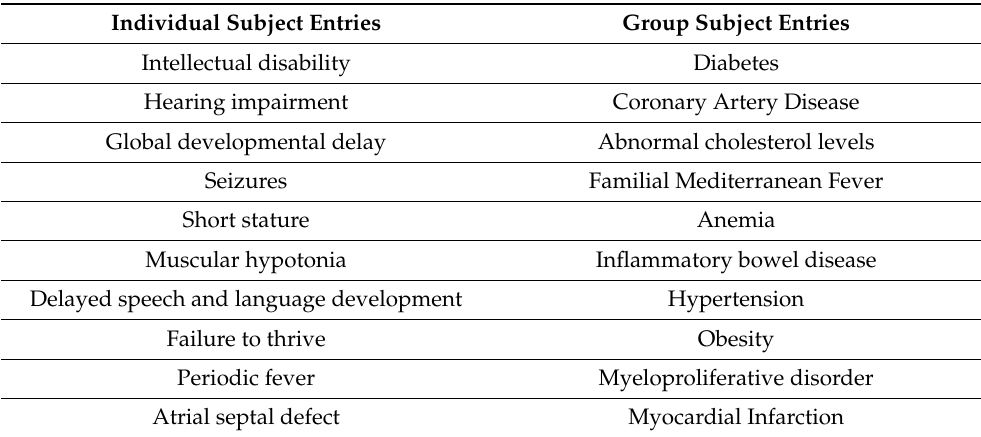
Table 2. Ten most prominent clinical features derived from HPO terms associated with Lebanese subjects in CTGA, ranked in decreasing order of occurrence. Ranking is based on the absolute number of individual subjects or subjects within a group, with each clinical